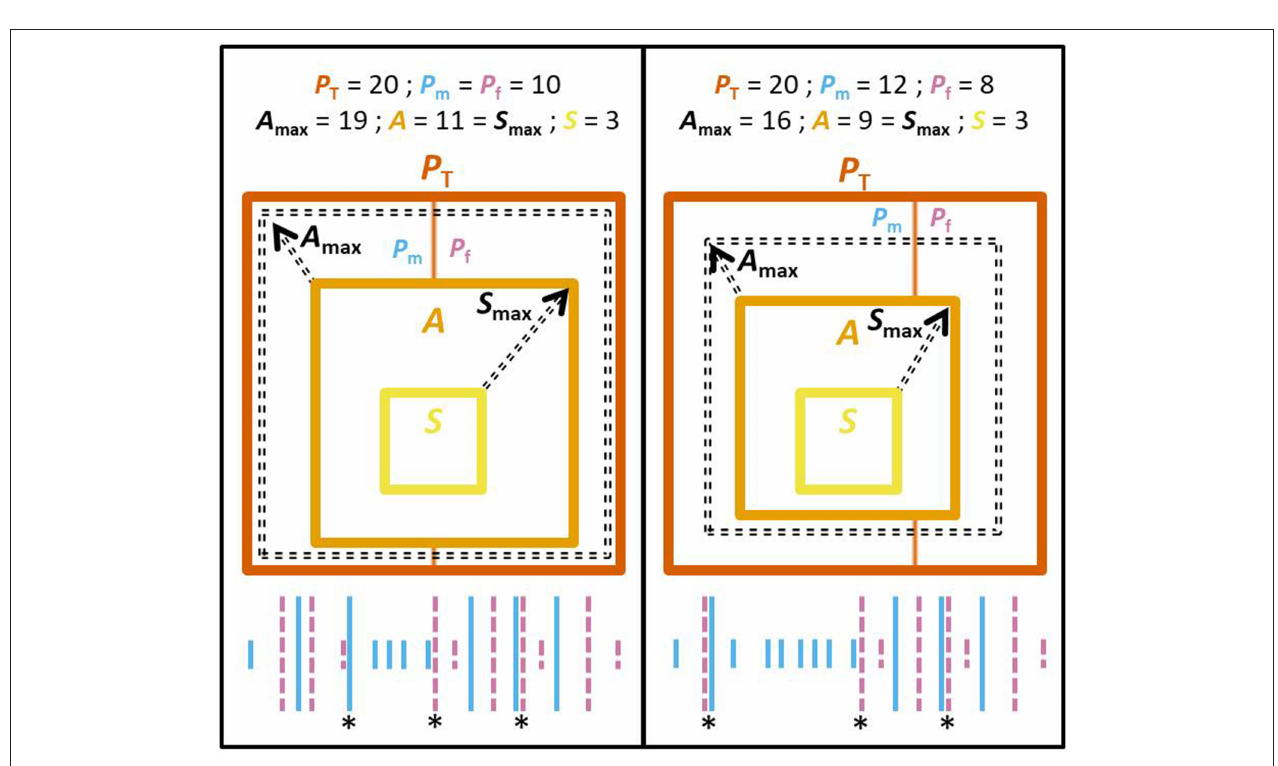
FIGURE 2 | (Center) Scheme illustrating the constraints on the range of values that the different mathematically related variables can take. Specifically, it represents the mathematical relationships between the total number of provisioning visits within a nest watch ( P T , area within dark orange squares) and the difference between male’s and female’s number of visits ( P m and P f , respectively; dividing the area of P T in 2 parts), with the number of alternated visits ( A , orange square) and synchronous visits ( S , yellow square). Square areas are proportionate to the number of visits (total, alternated, or synchronized). The number of alternated and synchronized visits can vary between 0 and the limit is indicated by broken arrows (broken square for A max , and observed alternation A for S max , respectively). (Bottom) Illustrative timeline of provisioning visits, with each bar representing a visit [female and male visits, in pink (dashed bar) and light blue (solid bar), respectively]. Longer bars represent alternated visits. Asterisks highlight synchronous visits. (Left) When P m = P f : A is bounded by P T - 1. (Right) When P m > P f : A is bounded by P T - | P m - P f |. In both cases, S is bounded by A